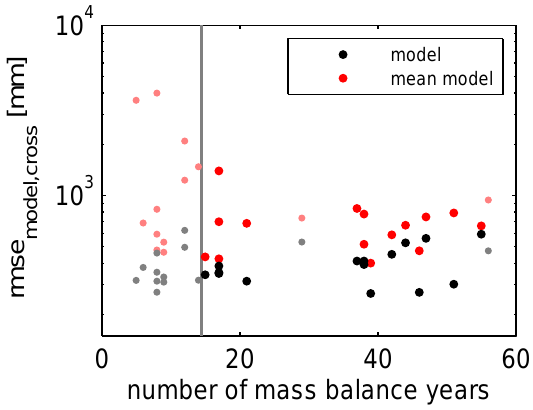
Fig. 5. rmse model , cross as a function of the number of MB measured . Black (red) dots are the values of the glaciers accepted into the final set, gray (light red) dots are those of the rejected glaciers. Red dots show the result of the mean model. The gray vertical line indicates the minimum number of mass balances necessary to yield robust results for a optimized and µ optimized .